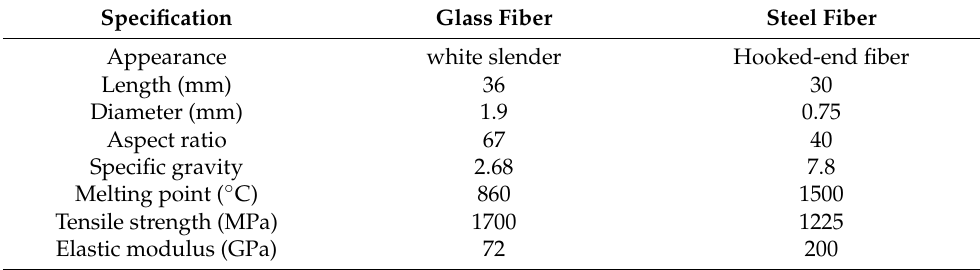
Table 3. Specification of the AR glass fiber and steel